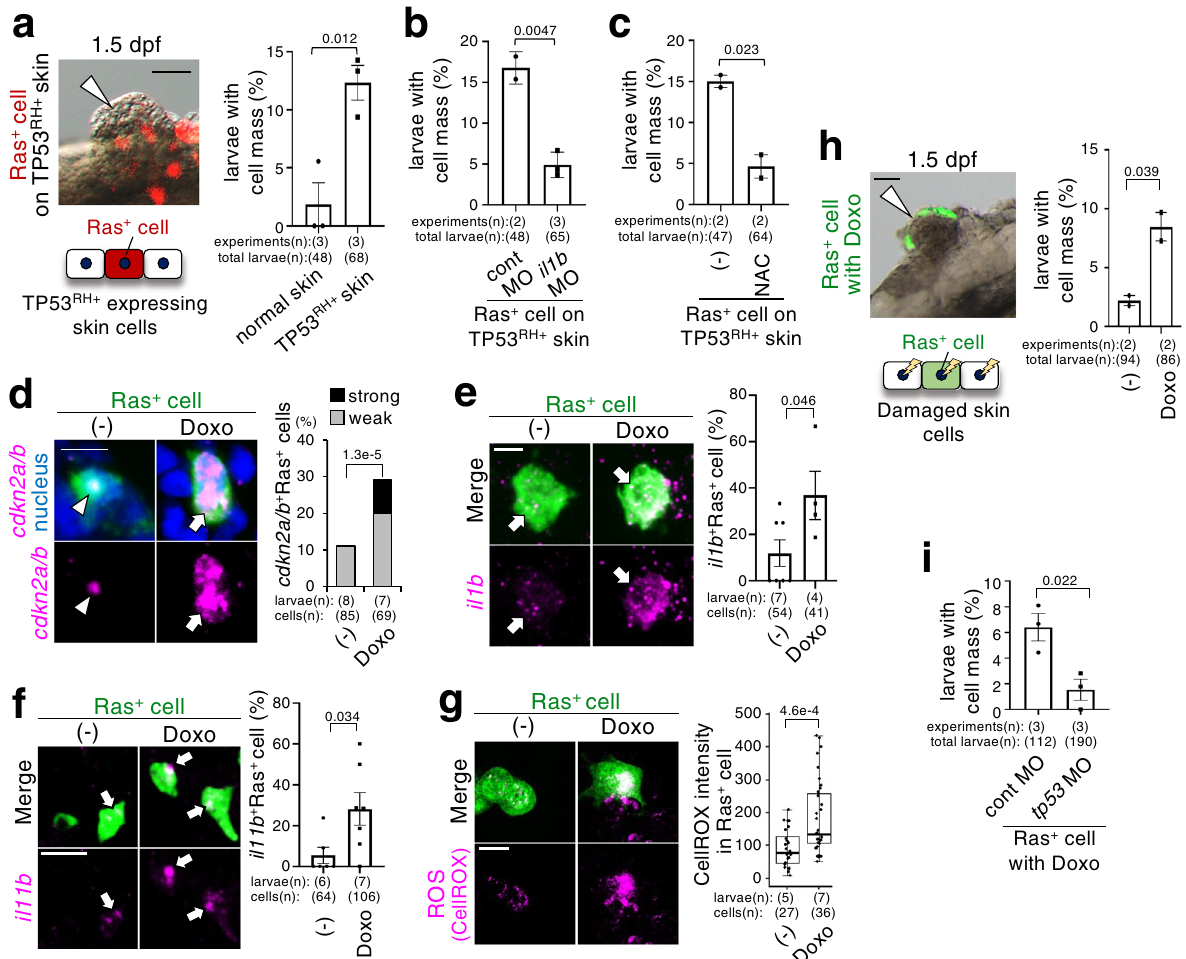
Fig. 6 Mosaic Ras G12V cells stimulate cell mass formation in damaged skin. a Representative images show cell mass in Tg( krt4p: gal4 ; UAS:G43EGFP- TP53 R175H ) larval head region with mCherry + Ras + (Ras + ) cells (red). Graph shows percentage of embryos with cell mass (mean ± SEM). b , c Tg( krt4p: :gal4 ; UAS:G43EGFP-TP53 R175H ) larvae with Ras + cells with control or il1b MO ( b ) or untreated or treated with NAC ( c ). Graph shows the percentage of 1.5 dpf embryos with cell mass (mean ± SEM). Each dot in graph ( a – c ) represents an independent experimental result. d – g Doxorubicin promotes senescence and SASP factor production in mosaic Ras + cells. In d , representative images show fl uorescence in situ hybridization for cdkn2a/b mRNA (magenta) in Ras + cells (green) with or without doxorubicin treatment, and nucleus (blue). Arrow and arrowhead indicate cdkn2a/b + Ras + cells weakly or strongly, respectively. Graph shows percentage of cdkn2a/b + Ras + cells. In e – f , representative images show fl uorescence in situ hybridization for il1b ( e ) or il11b mRNA ( f ) (magenta) in Ras + cells (green) with or without doxorubicin treatment. Arrows indicate il1b + Ras + or il11b + Ras G12V cells. Graph shows percentage of il1b + Ras + or il11b + Ras G12V cells (mean ± SEM). Each dot represents one larva. In g , representative images show ROS-probe, CellROX (magenta), -stained larvae with Ras + cells (green) with or without doxorubicin treatment. Box plots of CellROX relative intensities in Ras + cells show fi rst and third quartile, median is represented by a line, whiskers indicate the minimum and maximum. Each dot represents one cell. h Representative images show cell mass in the head region of doxorubicin-treated larvae with GFP + Ras + (Ras + ) cells (green). Right graph shows percentage of embryos with cell mass (mean ± SEM). i Doxorubicin-treated larvae with Ras + cells with control or tp53 MO. Graph shows percentage of 1.5 dpf embryos with cell mass (mean ± SEM). Each dot in graph ( h , i ) represents an independent experimental result. Note that cell mass formation was induced not only in the head but also in the trunk and tail in TP53 R175H -expressing and doxorubicin-treated skin. Scale bar: 50 ( a , h ) or 10 ( d – g ) μ m. Unpaired two-tailed t -test ( a – c , e – i ) or Fisher ’ s exact test with Benjamini – Hochberg correction ( d ) was used. Source data are provided as a Source Data fi le. SASP factors, including IL-1 β and ROS (Fig. 7, middle). Addi- Previous studies revealed two tumour-suppressive mechanisms tional TP53 mutation-mediated survival of mutant cells would of cellular senescence. The fi rst is induction of cyclin-dependent assist in the continuous high-level secretion of IL-1 β and ROS to kinase inhibitor-mediated irreversible cell cycle arrest in onco- the neighbours. Neighbouring cells undergo proliferation or genic cells 14 – 17 . The second is stimulation of immune cell- senescence in response to IL-1 β or ROS, respectively. Secondary mediated senescent cell elimination 58,59 . In this study, we found senesced cells also secrete IL-1 β and ROS, which can propagate that immune cell-independent oncogenic cell elimination is a cellular senescence and stimulate aberrant cell proliferation third antitumour mechanism of cellular senescence. Interestingly, nearby, resulting in formation of a heterogeneous tumour-like cell similar elimination was triggered by activation of Src in the mass. Similar heterogeneous cell mass formation depending on zebra fi sh epithelia. Cells with hyperactive Src may be eliminated IL-1 β and ROS occurs in abnormal zebra fi sh skin with through cellular senescence because these signalling pathways are TP53 R175H mutation or DNA damage (Fig. 7, right). also involved in senescence induction 60 . In contrast, zebra fi sh NATURE COMMUNICATIONS| (2022) 13:1417